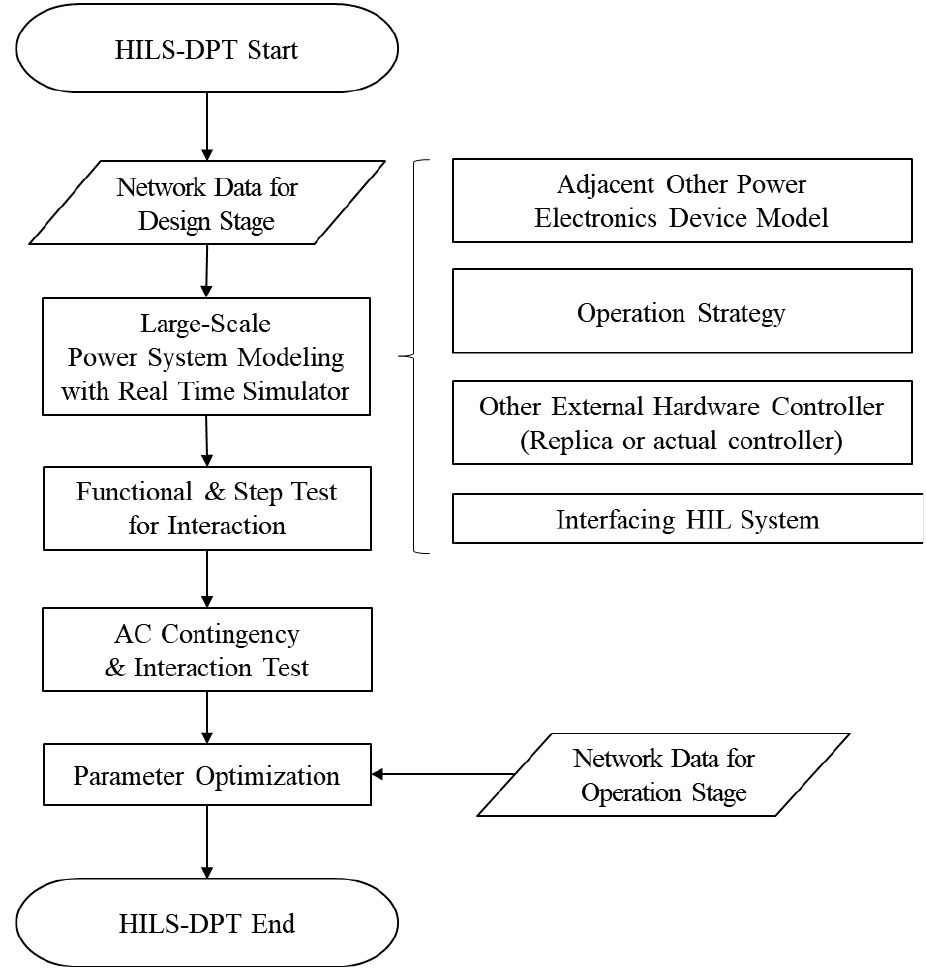
Figure 2. The entire procedure of hardware-in-the-loop simulation for dynamic performance test (HILS-DPT) using a large-scale real-time simulator (RTS).